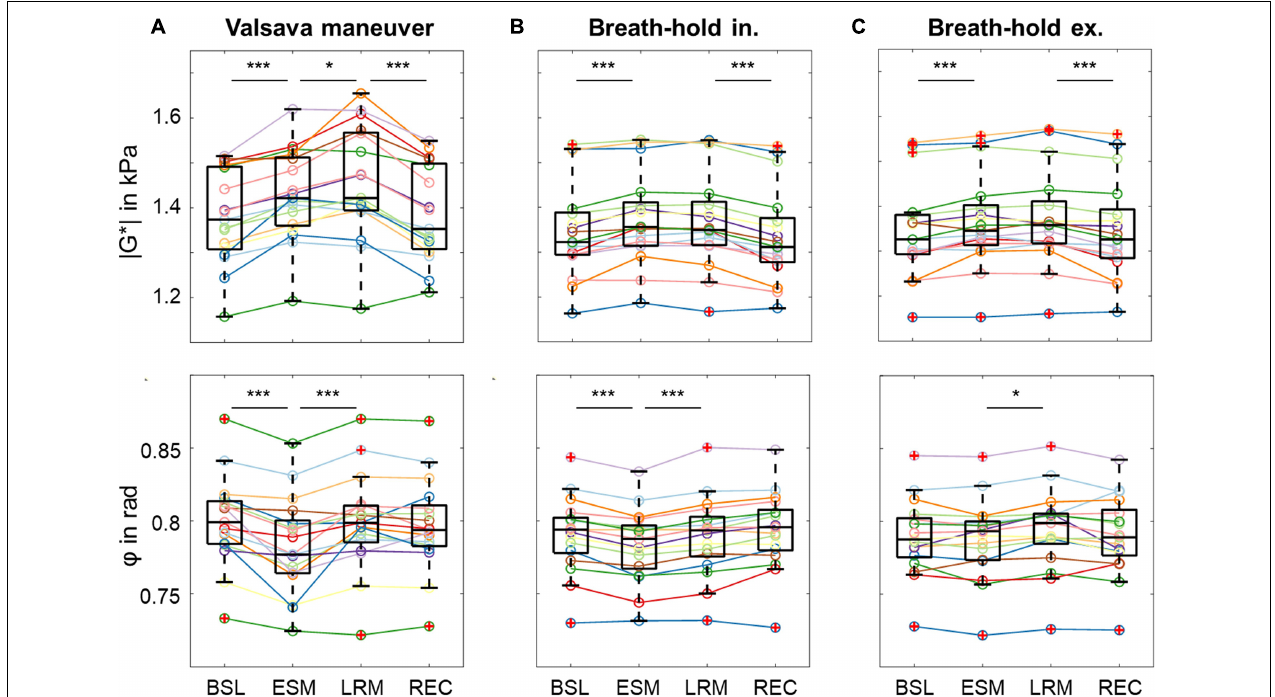
FIGURE 6 | Group values as boxplots for the absolute values of | G*| (top) and ϕ (bottom) in each phase illustrate the changes in viscoelastic properties induced by the different maneuvers using the 31-Hz regimen for each phase [baseline (BSL), established maneuver (ESM), late response maneuver (LRM), recovery (REC)]. (A) Valsalva maneuver (VM). (B) Breath-hold in inspiration (BH-in). (C) Breath-hold in expiration (BH-ex). Asterisks at the top demarcate significant changes in | G*| and ϕ which were determined from a linear mixed-effects model with varying intercept. | G*| and ϕ assigned dependent variables and the individual phases as independent variables. Participants were assigned as random effect, and P -values were calculated using Tukey’s post hoc test with Bonferroni correction for multiple comparisons. (* P < 0.05, *** P < 0.001).